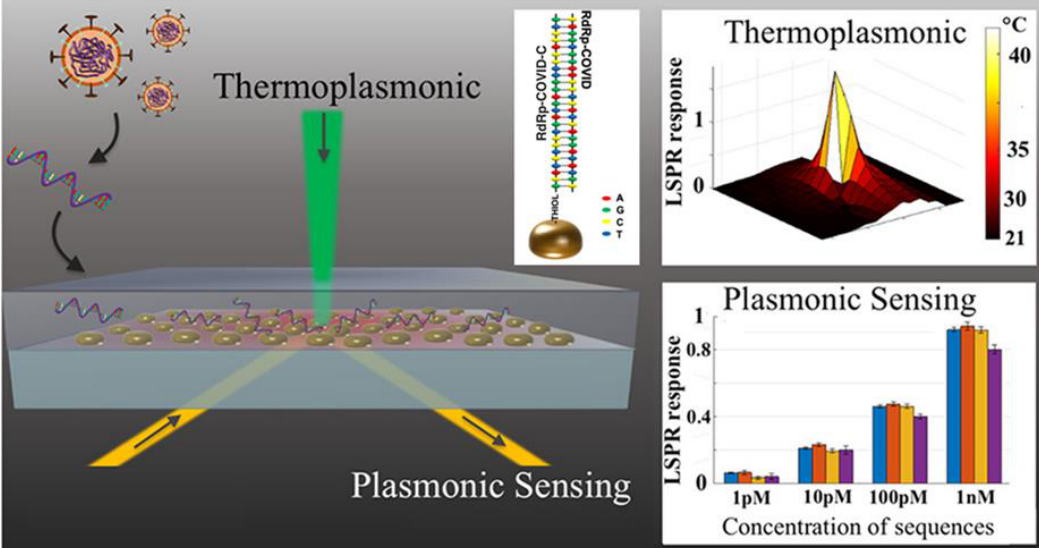
Figure 9. Working principle of SARS-CoV-2 sensor based on two-dimensional (2D)-surface Au nanoislands conjugated with thiolated cDNA acting as the capture probe: once DNA hybridization takes place owing to the thermoplasmonic effect, the induced Localized Surface Plasmon Resonance (LSPR) response is correlated to the concentration of the targeted sequences of SARS-CoV-2. Adapted from Reference [212] with permission from the American Chemical Society (ACS).